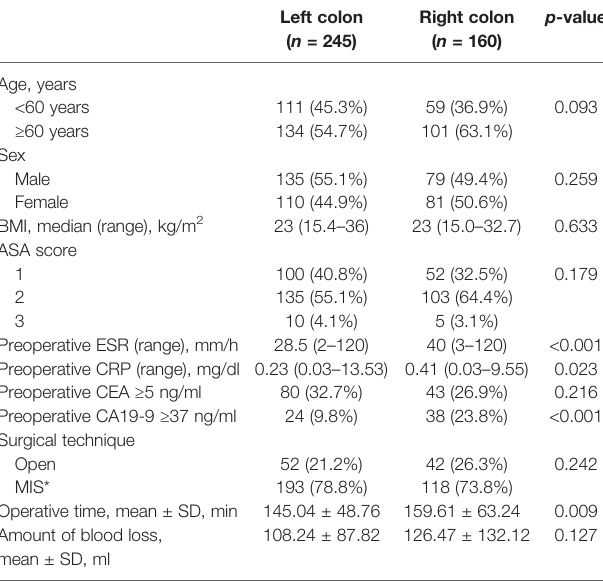
TABLE 4 | Postoperative outcomes of incomplete obstructive colon cancer (IOCC) by tumor location.